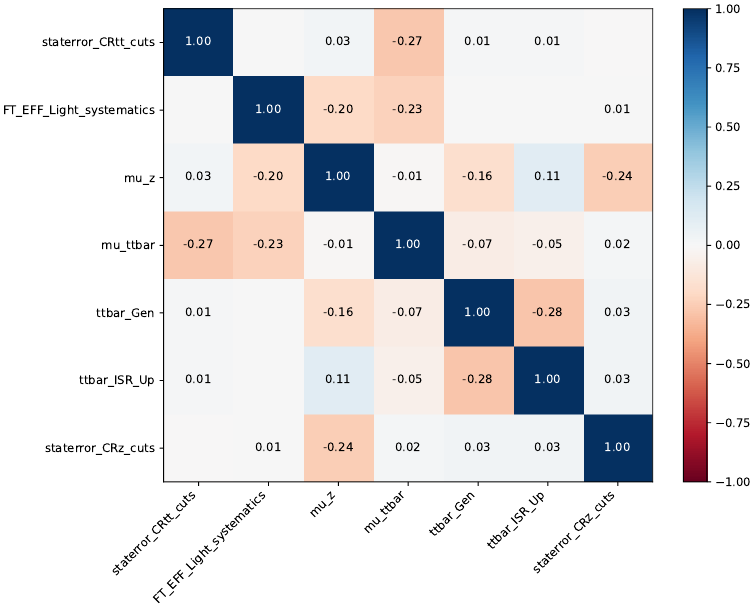
Figure 4: Post-fit visualizations of the leading nuisance parameter correlations gener- ated from the full statistical models published in Ref. [ 20 ] using code from Ref. [ 40 ] . For better visualization, the nuisance parameter correlations shown are for the model nuisance parameters that have a correlation with any other nuisance parameter greater than 0.2 in